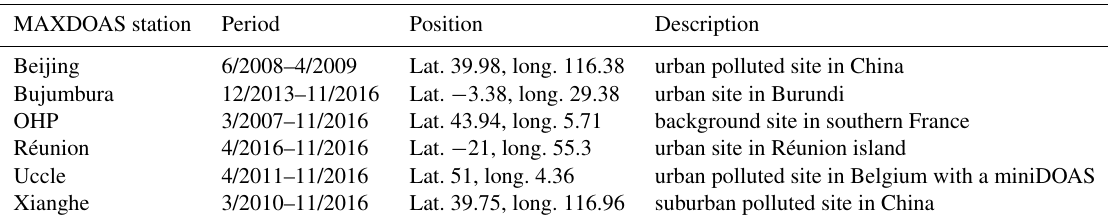
Table 3. An overview of BIRA-IASB MAXDOAS datasets used in this study.